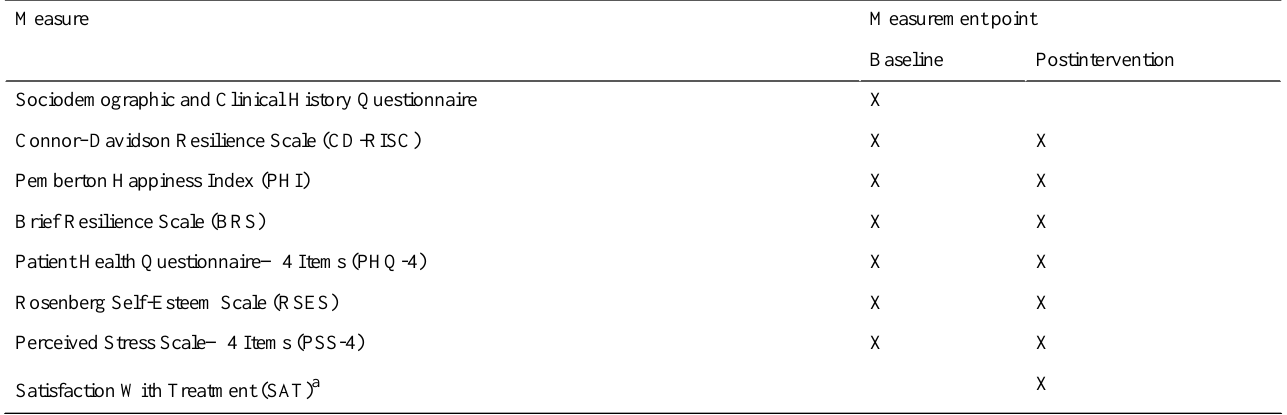
Table 1. Measure administration